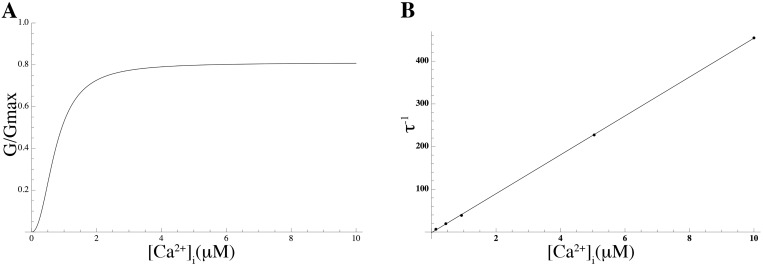
Properties of ISK2.(A) Activation variable as a function of [Ca2+]i obtained from experimental data of Hirschberg et al [22] as function of [Ca2+]i. (B) Activation time constant obtained from simulated current traces as function of [Ca2+]i.